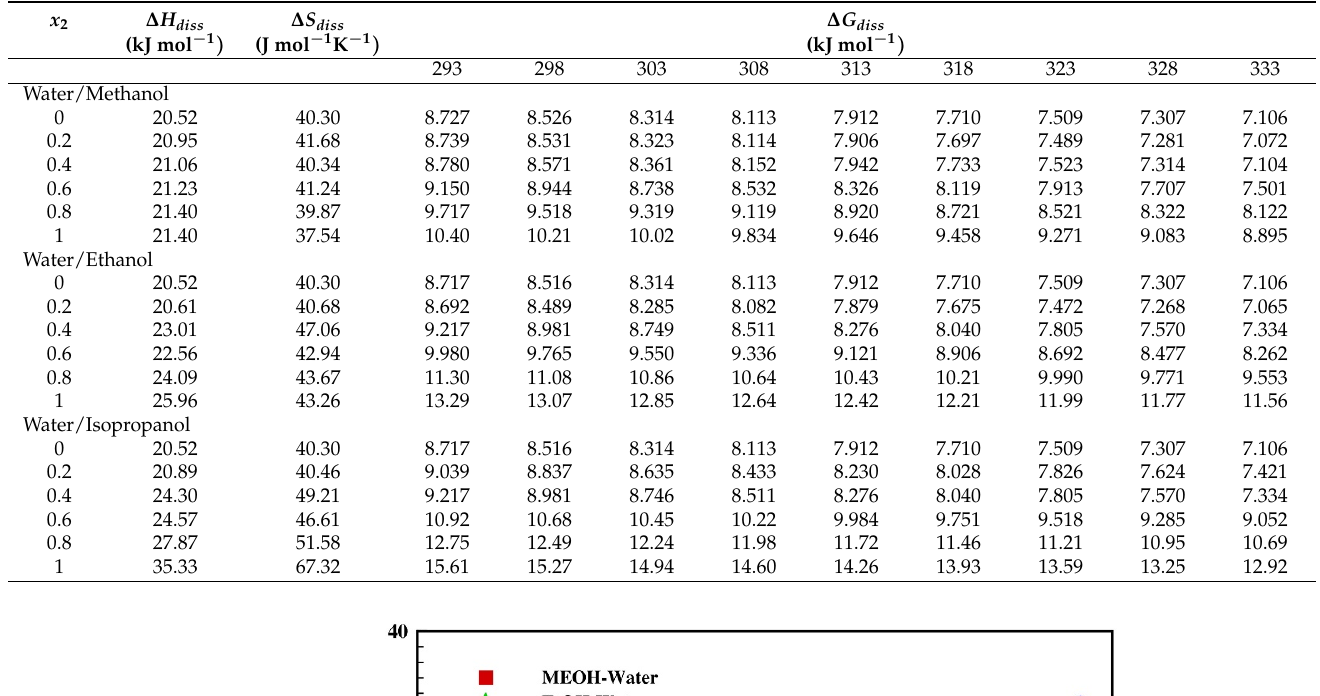
Table 3. Thermodynamic properties of ascorbic acid in three water-alcohol systems using Van’t Hoff plot.